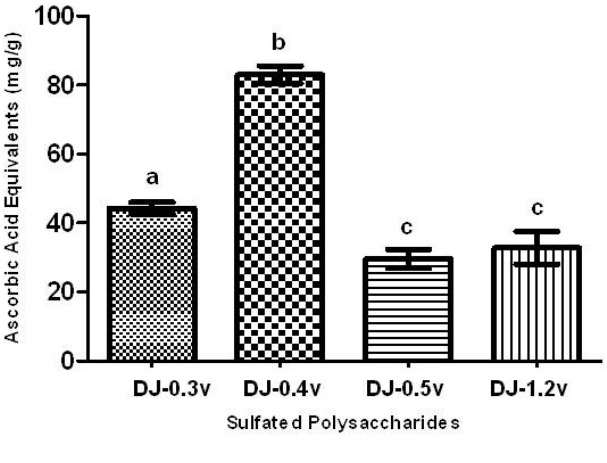
Figure 1. Total antioxidant capacity of sulfated polysaccharides extracted from the marine brown seaweed D. justii . The results are expressed as AAE. Each value is the mean ± SD of three determinations: Different letters ( a , b , c ) indicate a significant difference ( p < 0.05) between sulfated